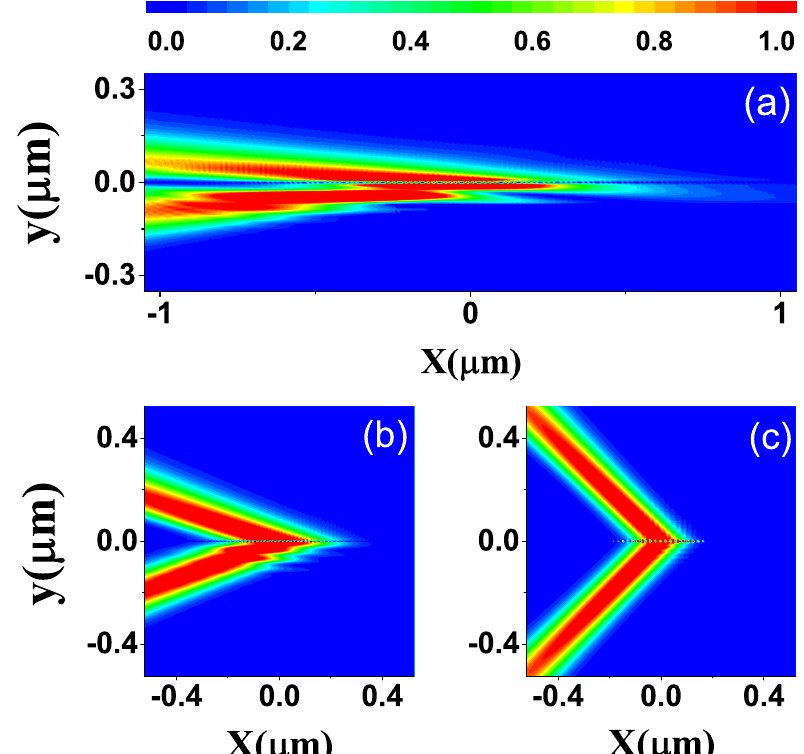
Fig. 2 Simulation of negative transmission. Negative-transmission-based de fl ection of electron beams at ( a ) θ WA = 5°, ( b ) θ WA = 20°, and ( c ) = 45°. The bias and the lattice spacing are ( a ) V = 977 meV and d = 14 nm, ( b ) V = 970 meV and d = 15 nm, and ( c ) V = 940 meV and d = θ WA 20 nm. In all the cases, the QD radius is R s = 3.5 nm and the incident electrons have a fi xed energy E = 148 meV. The Gaussian beam has a waist radius w = 3 λ .